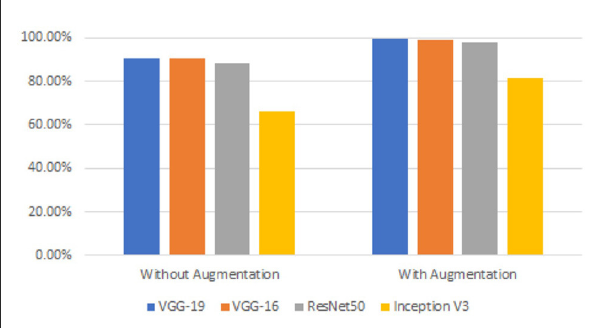
FIGURE16 Comparison of model accuracies with and without augmentation.